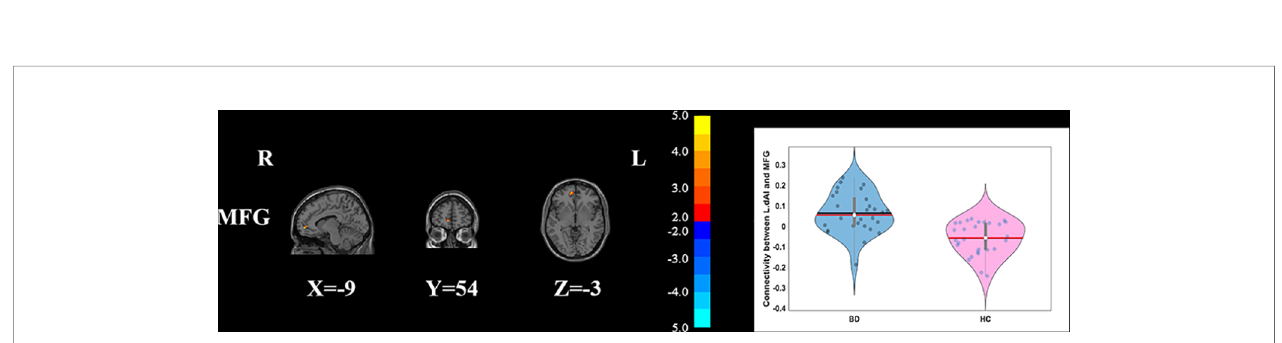
FIGURE 2 | Group differences of the whole-brain functional connectivity anchored in L_dAI: compared to HCs, BD patients had signi fi cantly higher functional connectivity between L_dAI and MFG (GRF corrected, p < 0.05, voxel Z value > 2.3). Red indicates larger values in BD. L, left; R, right; BD, bipolar disorder; HC, healthy control; L_dAI, left dorsal anterior insula; MFG, middle frontal gyrus; GRF, Gaussian random fi eld.